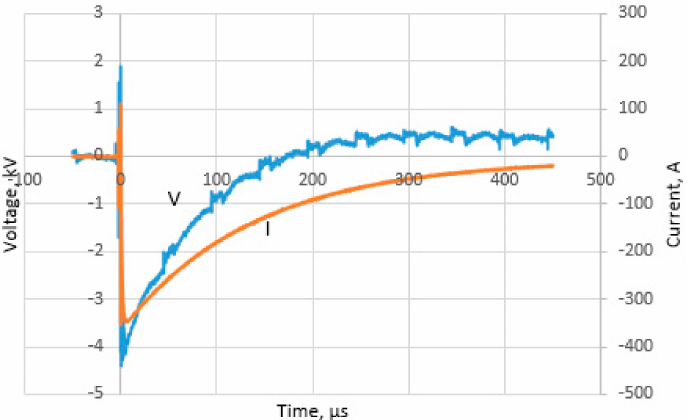
Figure 14. Voltage and current traces of negative polarity for electrodes installed at site 1, at a charging voltage of 30